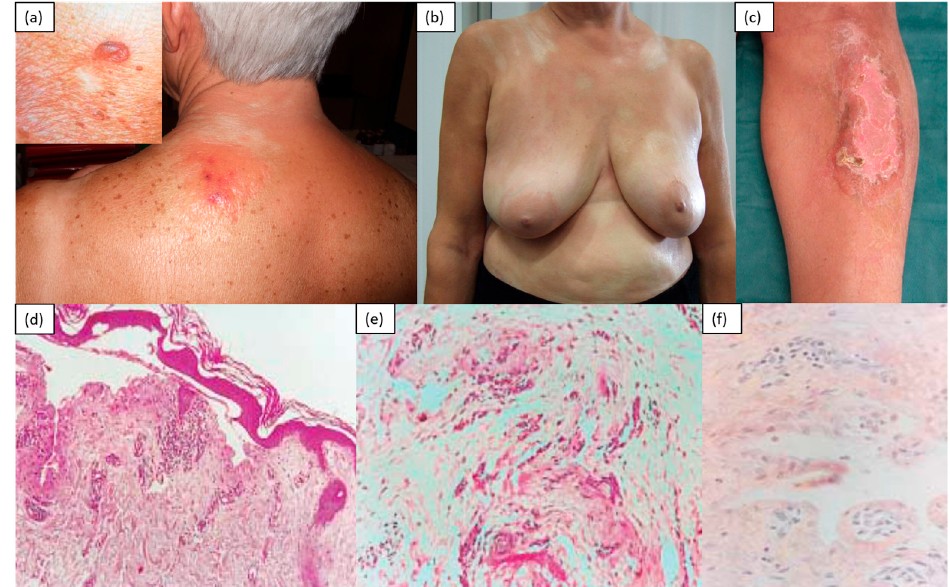
Figure 6. A 73-year-old female patient. For about 2 years, there had been the appearance of a hard- ened and infiltrated plaque on the left shoulder blade, with evidence of a hemorrhagic bubble ( a ), scleroatrophic patches on the trunk ( b ) and firm erythematous brown plaque with sharp edges in the left pretibial region ( c ). Sub-epidermal bulla (stained with hematoxylin-eosin; original magnifi- cation, 100×) ( d ); amyloid birefringent deposits in polarized light (stained with Congo red; original magnification, 400×) ( e ); eosinophilic deposits in the bulla (stained with hematoxylin-eosin; original magnification, 200×) ( f ).